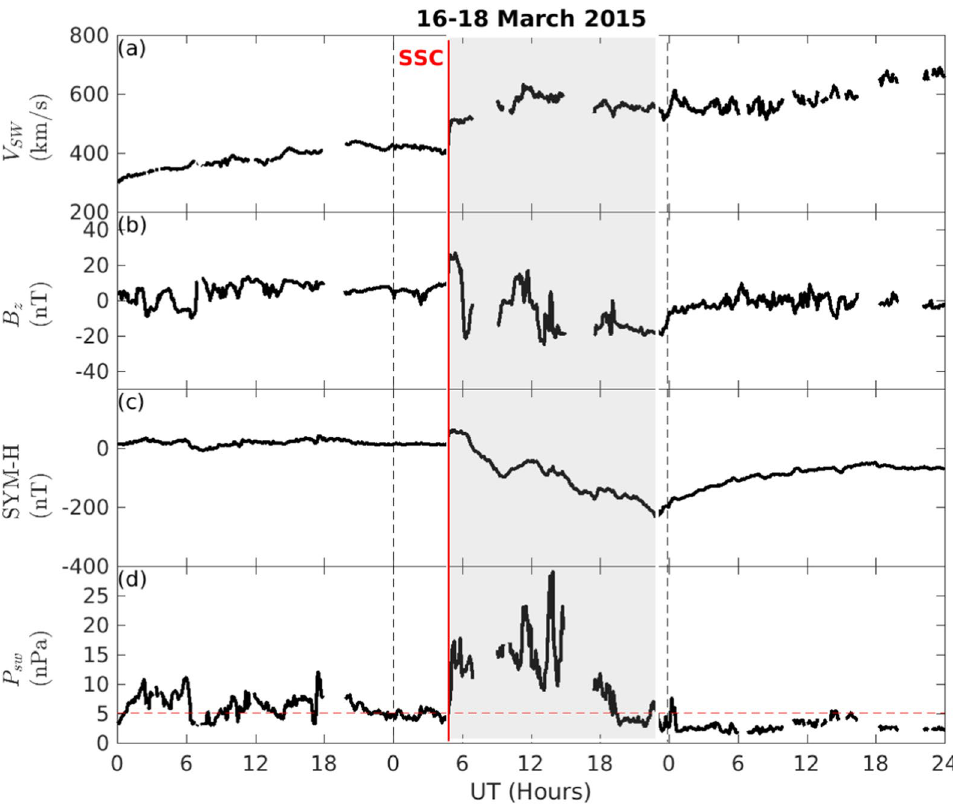
Fig. 2 Same as Fig. 1 but for a severe geomagnetic storm that occurred between 16–18 March